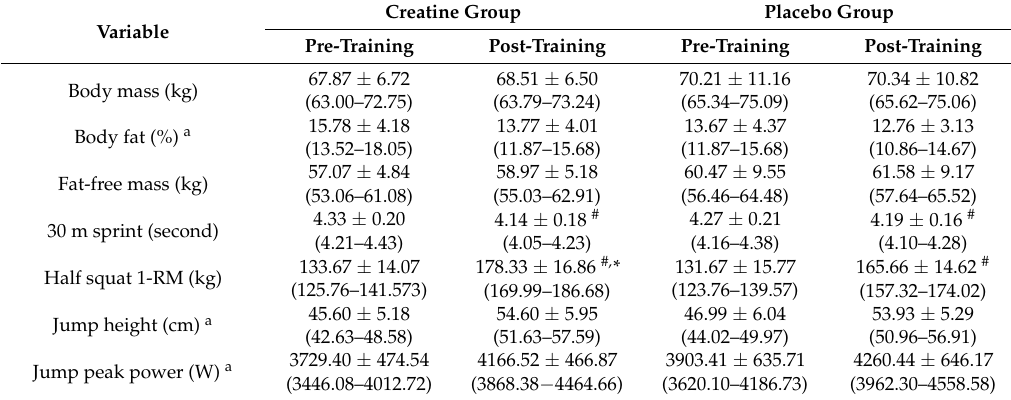
Table 3. Body composition and sport performances in the creatine and placebo groups after 4 weeks of complex training.